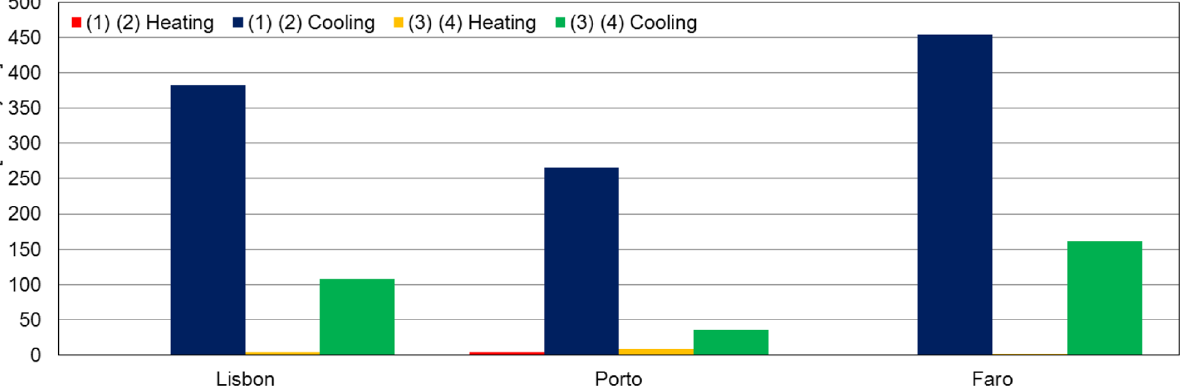
Fig. 4. Annual heating and cooling loads without NV (Scenarios (1) and (2)) and with NV (Scenarios (3)